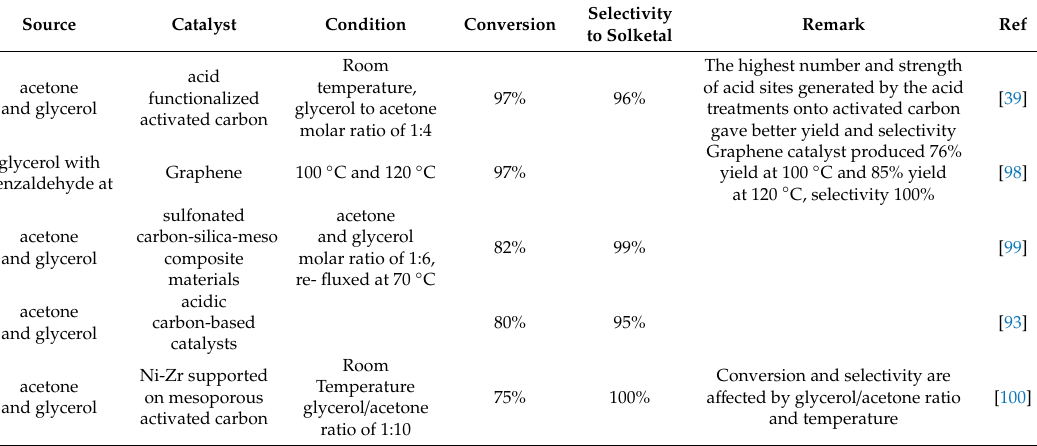
Table 7. Glycerol-to-solketal over carbon / activated carbon-based